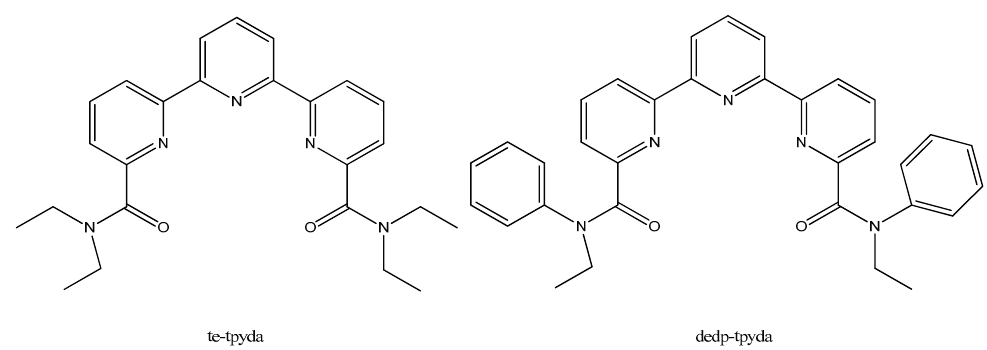
Figure 14. Structure of tpy